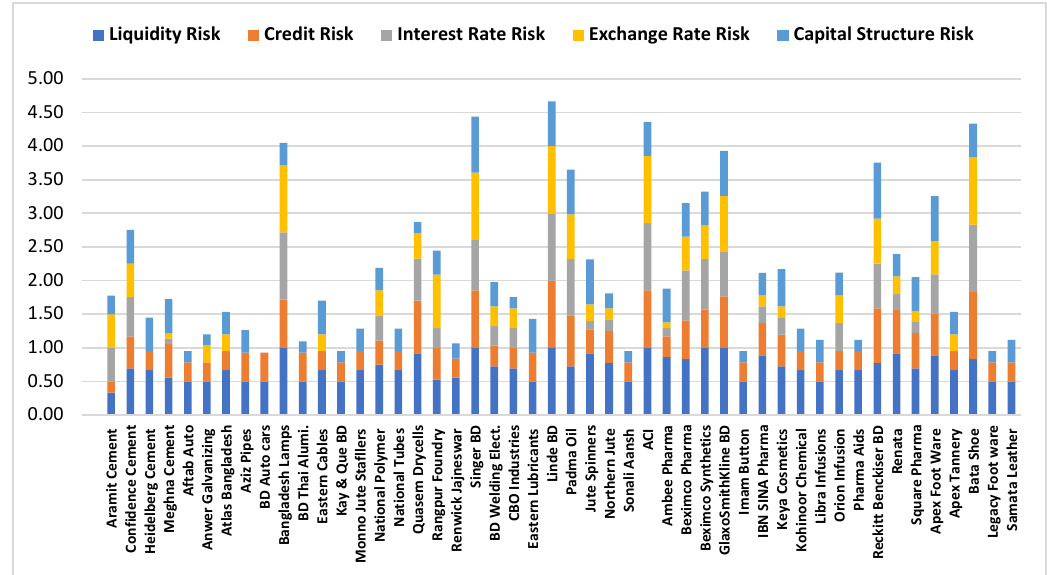
Figure 2. Accumulation of disclosure indices for individual financial risk during the study period of 2010 to 2015 for each company.